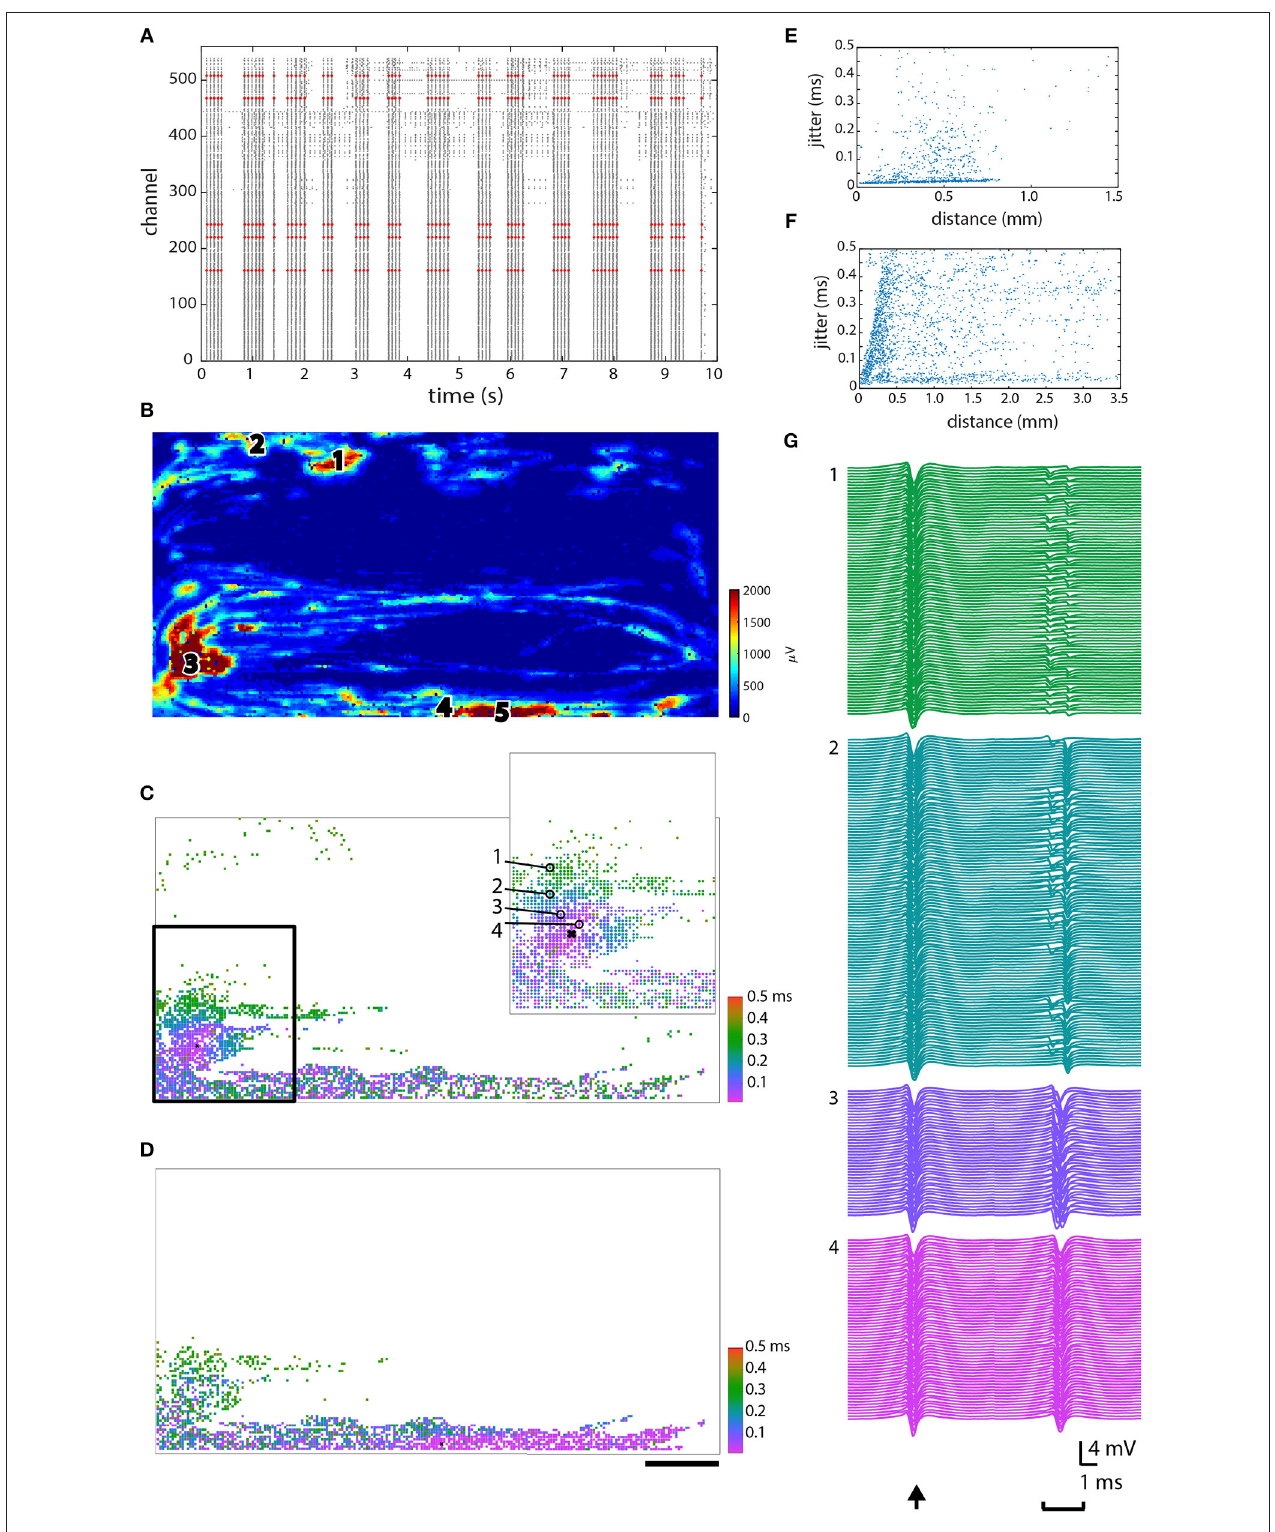
FIGURE 5 | Jitter analysis. (A) Raster plot showing 10s of data, with the five electrodes in high spiking areas that were chosen for further analysis plotted in red. (B) Spatial configuration demonstrating where each of the chosen electrodes was located. (C,D) The jitter on electrode 3 and 4, respectively, as indicated in (B) . (E,F) Jitter vs. distance plotted for electrodes 2 and 3, respectively, as indicated in (B) . (G) Signals from the circled electrodes (1–4) in C inset vs. the “zero point” that signals were aligned to (indicated with an “x”), to demonstrate the actual measured jitter, as shown in (C) . Scale bar in D is 0.5mm and applies to (B–D) .